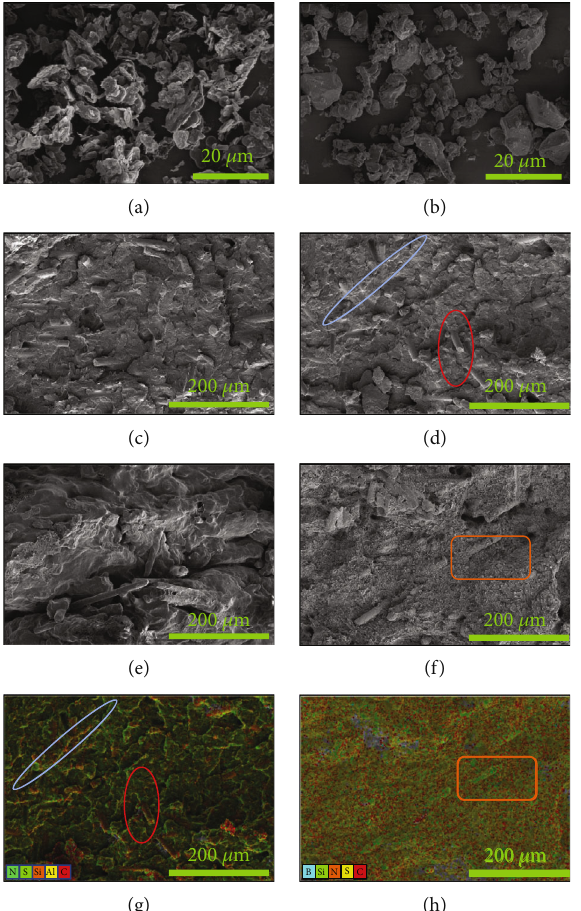
Figure 4: FE-SEM cross-sectional images of PPS-2COOH/LGF/AlN and PPS-2COOH/LGF/BN composite fi lms: (a) BN (20 μ m); (b) AlN (20 μ m); (c) PPS-2COOH/LGF/AlN (15) (200 μ m); (d) PPS-2COOH/LGF/AlN (20) (200 μ m); (e) PPS-2COOH/LGF/BN (15) (200 μ m); (f) PPS-2COOH/LGF/BN (20) (200 μ m); (g) EDS mapping of (d) (200 μ m); (h) EDS mapping of (f) (200 μ m). 0.00.10.20.30.40.50.60.70.8